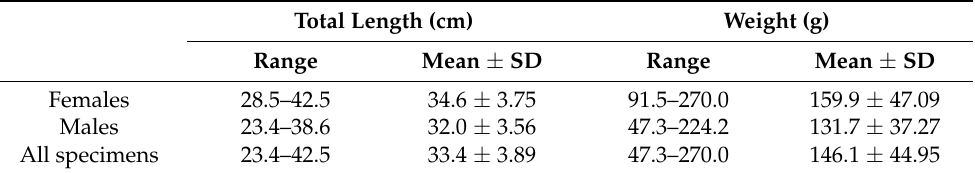
Table 1. Range of total length and weight and mean total length and weight with standard deviation (SD) of the European barracuda, Sphyraena sphyraena , in the eastern Adriatic. Total Length (cm)